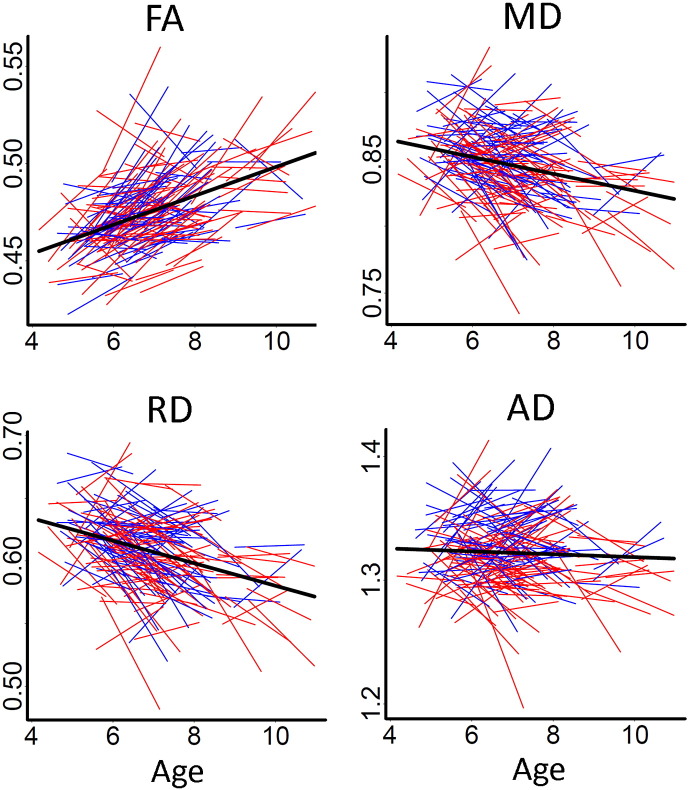
Spaghetti plots of change in mean FA, MD, RD and AD with age.Spaghetti plots of individual participant change in mean FA, MD, RD and AD with age (years). Females are plotted in red and males in blue. For each measure, an assumption-free general additive mix model as a function of age was fitted to accurately describe changes across the age range. Diffusivity values for MD, RD and AD are in 10− 3 x mm2/s.